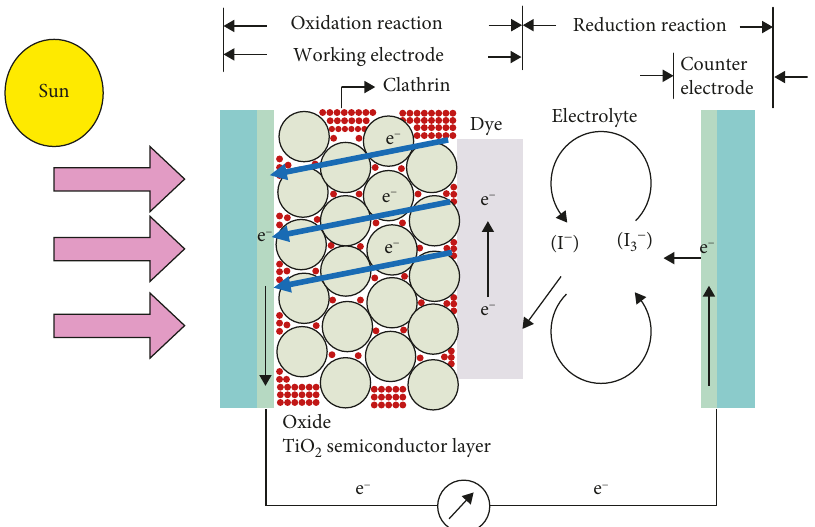
Figure 4: Mechanism of DSSC with the addition of clathrin.